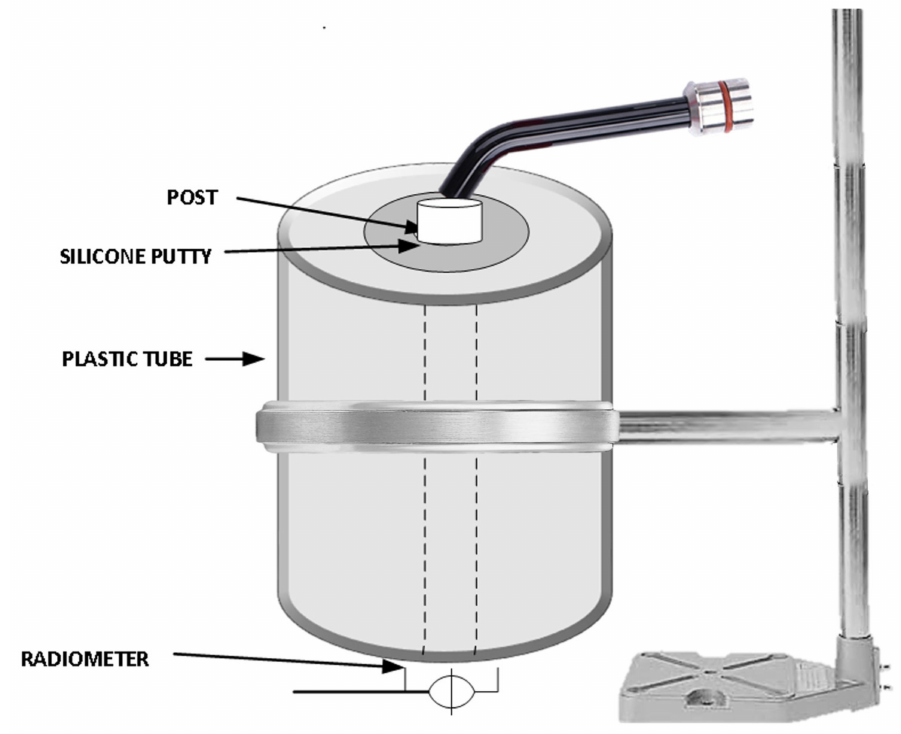
Figure 1. Schematic illustration of the Light transmission measurement